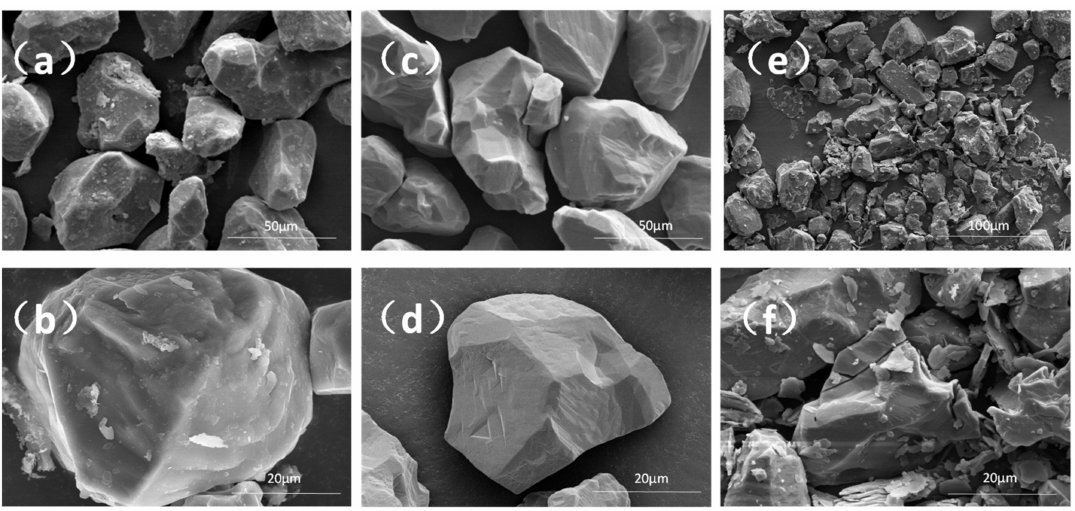
Figure 6. SEM images of concentrate and T2 in different conditions, ( a,b ) concentrate without scrubbing, ( c,d ) concentrate with scrubbing, ( e,f ) T2 of No. 2.